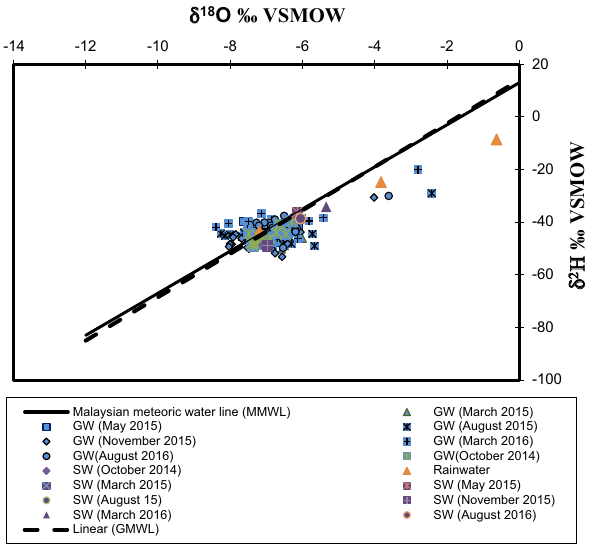
Fig. 2 The isotopic data for precipitation (rainwater),